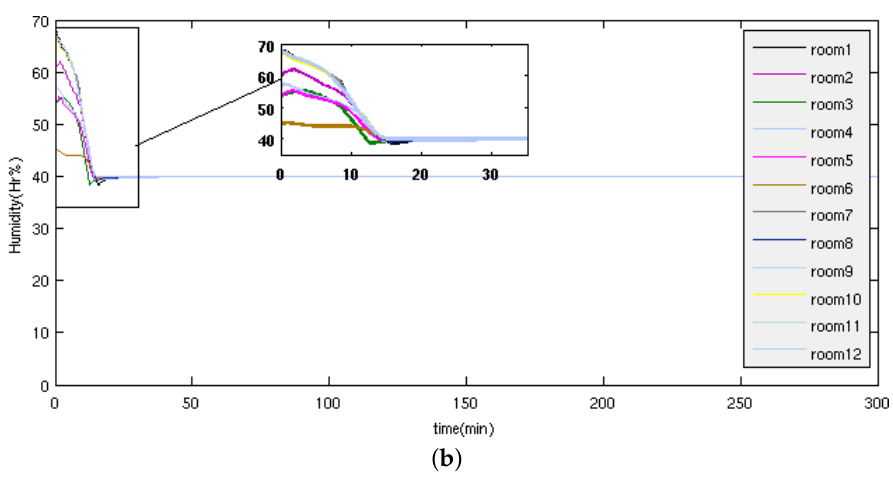
Figure 7. The numerical simulation lines represent the temperature and humidity in each room. Conditions are similar to the case of the seven rooms controlled previously. ( a ) Simulation results of the fuzzy control of temperature on 12 closed control loops in the rooms; ( b ) simulation results of the fuzzy control of humidity on 10 closed control loops in the rooms.